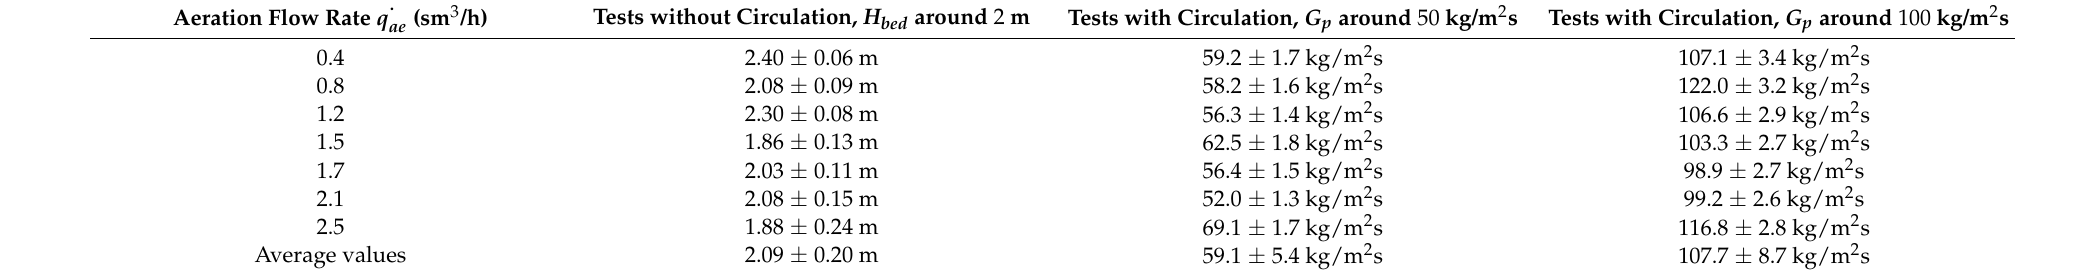
Table 2. Operating parameters of the experimental